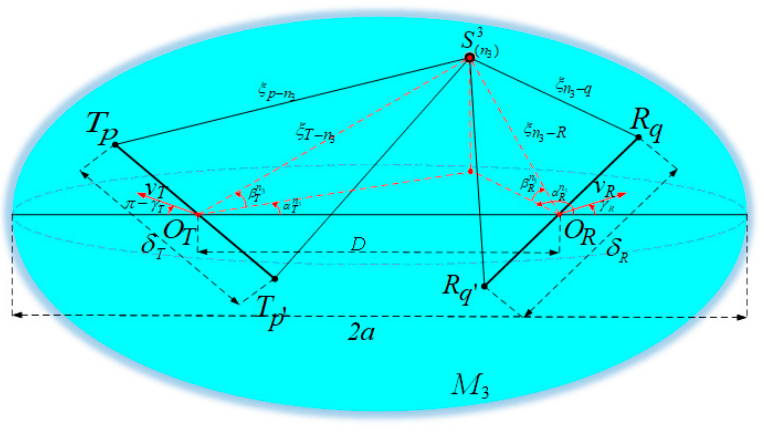
Figure 2. Proposed 3D ellipsoid model capturing remote scatterer distribution for mobile IoT scenar- ios.